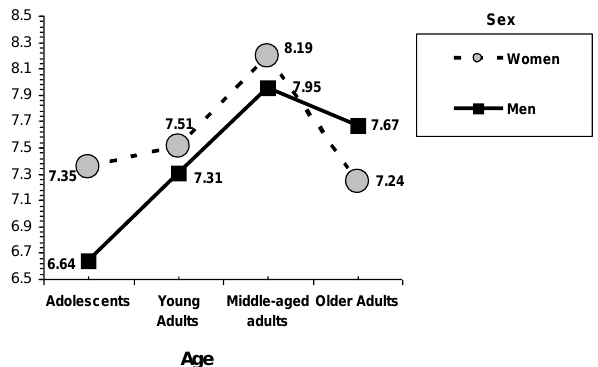
Figure 1. Interactions of sex and age. Academic/professional self-concept. In the interaction between sex and age group on delinquency during adolescence (see Figure 2), it is generally found that females tend to have lower scores than males. The greater scores were reported by young adults, especially among males. The lowest scores in delinquency during adolescence were reported by older adults for both males and females. Adolescents and middle-aged adults had similar scores, lower than adolescents (a tendency especially remarkably for males), but higher than older adults (see Figure 2).